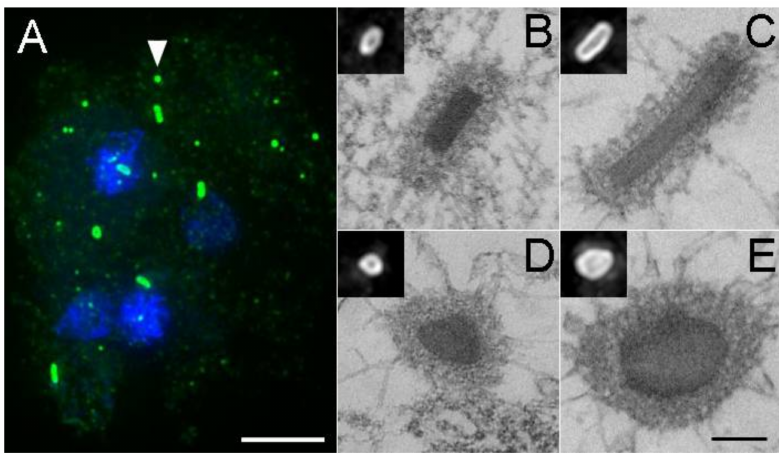
Figure 6. Aberrant centrosome formation. Panel ( A ) shows a tetranucleated cell with supernumerary centrosomes (green, DdCP224 staining, DdKif9 null background). The arrowhead highlights the normal appearance for an interphase centrosome. Note here the number, distribution, and variability in centrosome sizes, as well as the lack of nuclear association. Scale bar = 5 µ m. Panels ( B – E ) show thin section electron micrographs of selected centrosomes. Scale bar = 250 nm ( B , D ) present side and top views of wild type centrosomes, ( C , E ) show elongated versions. Insets show the same centrosomes by light microscopy. Panels ( B , D , E ) adapted with permission from Ref